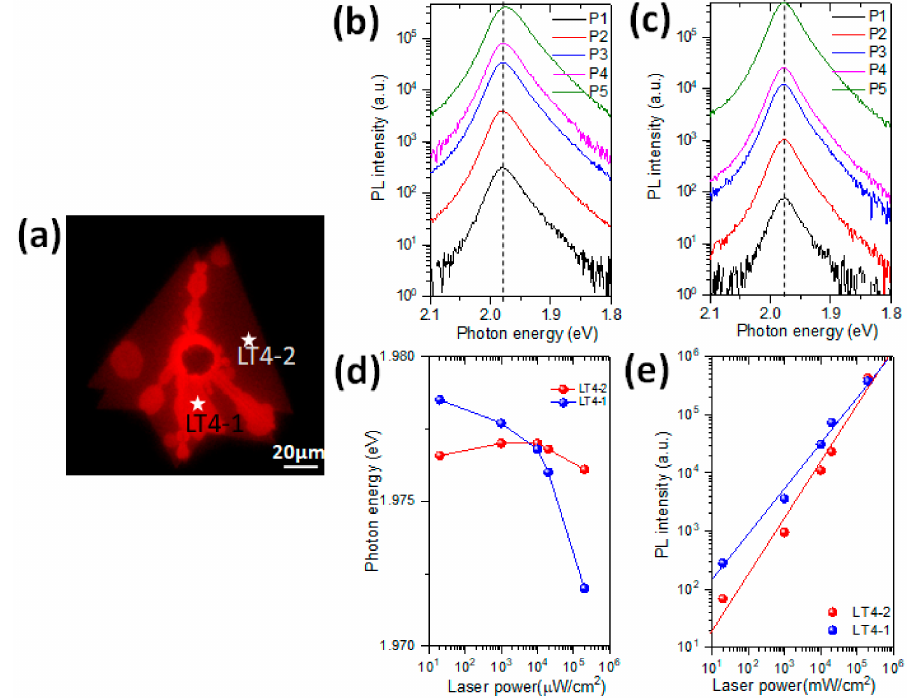
Figure 4. ( a ) Photoluminescence microscopy image of a WS 2 1 L flake (flake T4 in Figure 3d), measured with LED irradiation, corresponding to low power); ( b , c ), PL spectra of points LT4-1 and LT4-2 with different laser power, respectively; ( d ) PL A band positions of points LT4-1 and LT4-2 at different excitation laser power density; ( e ) PL A band intensities of points LT4-1 and LT4-2 as a function of different laser power densities (symbols), fitting using a function of I = P m (solid line). Note that in ( b , c ), the PL intensities are plotted in logarithmic scale to clearly show the PL intensity change. The laser powers are P1 = 0.02 µ W, P2 = 1 µ W, P3 = 10 µ W, P4 = 20 µ W and P5 = 200 µ